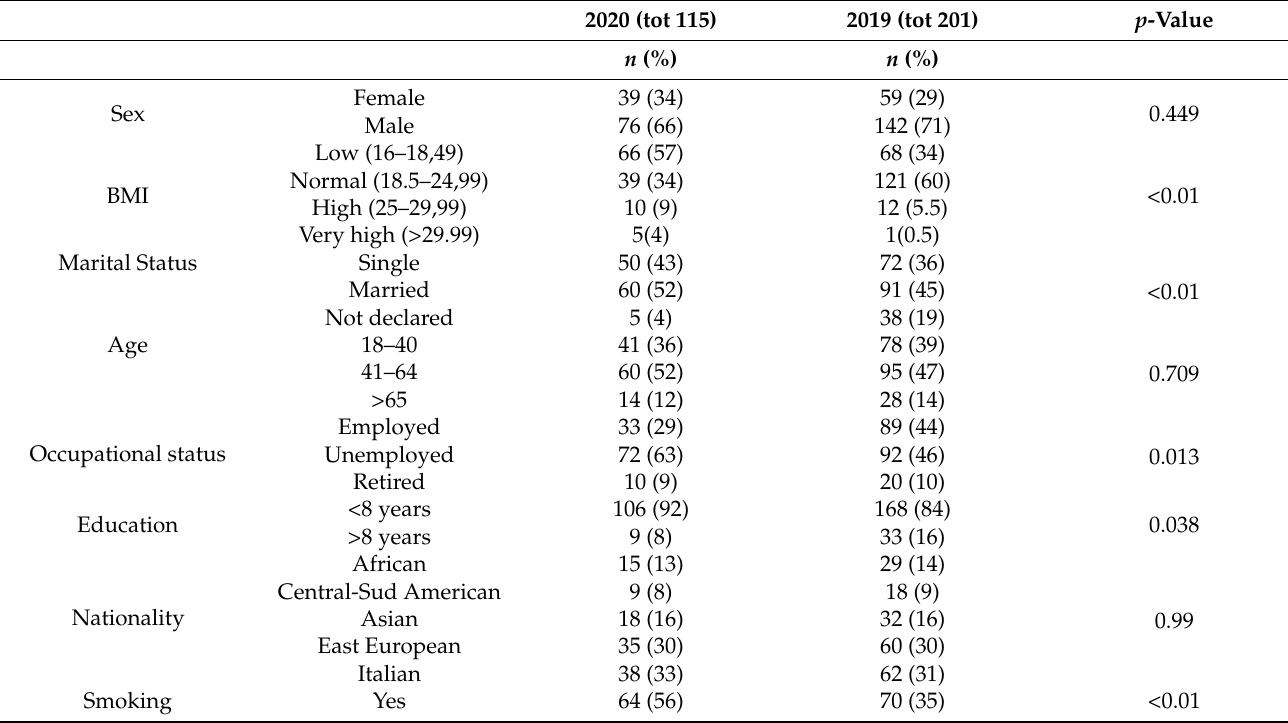
Figure 1. TB cases March August 2019–2020. Table 1. Population